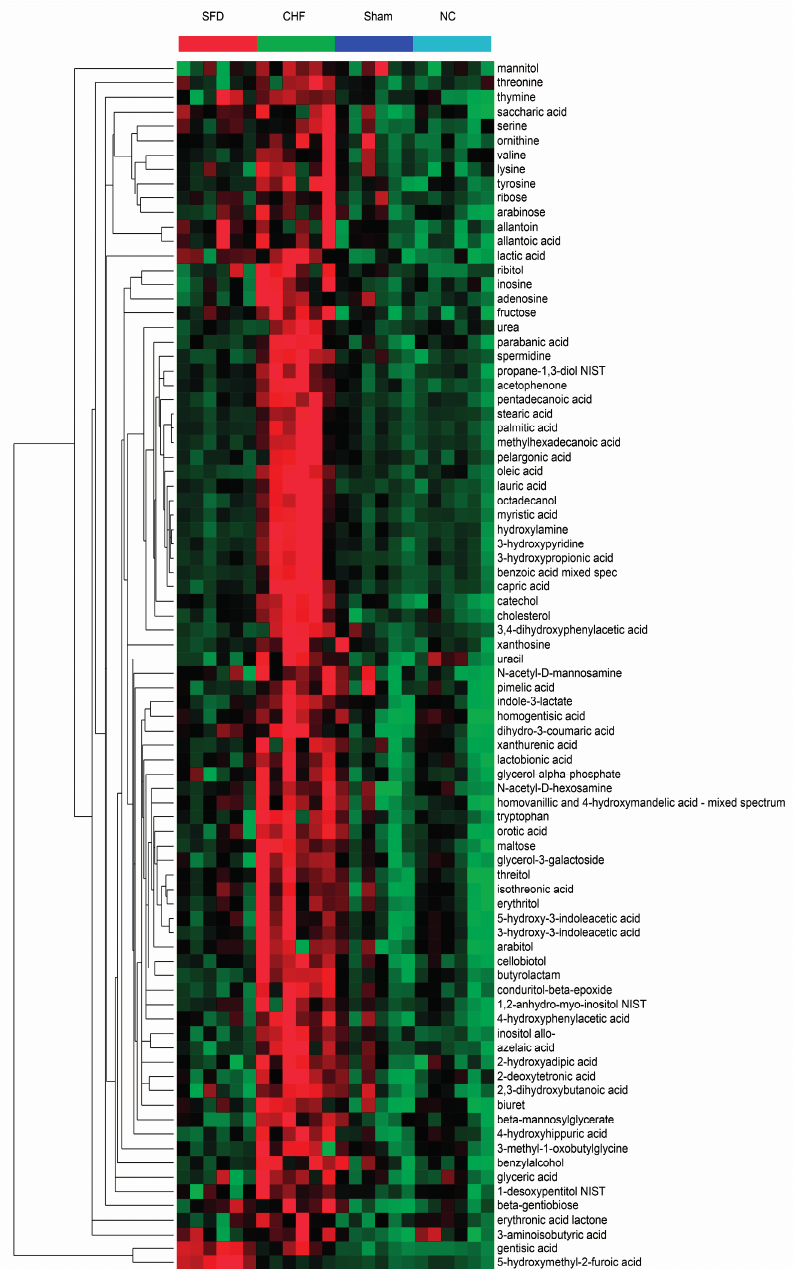
Figure 3. Heat maps showing the 84 significantly-altered metabolites based on ANOVA. Color from green to red represent the intensity of these metabolites from low to high levels in the analysis. CHF, CHF group; NC, normal control group; Sham, sham surgery group; SFD, SFD-treated group. Red dots, SFD-treated group (SFD); Green dots, CHF group (CHF); Light blue dots, normal control group (NC); Dark blue dots, sham surgery group